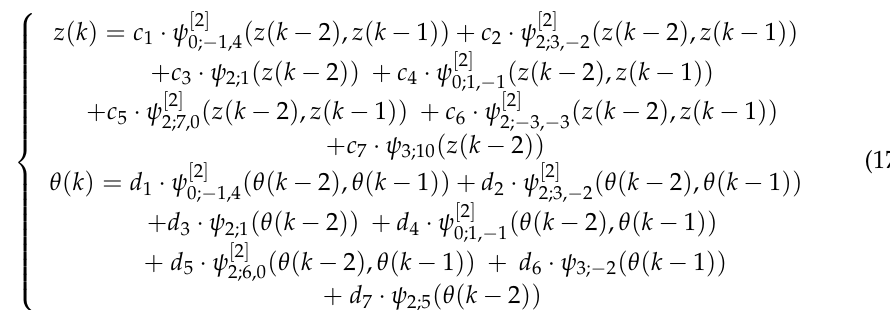
Figure 13. The coupled heave-pitch motions of the FPSO model in irregular waves. The identified model is as follows: